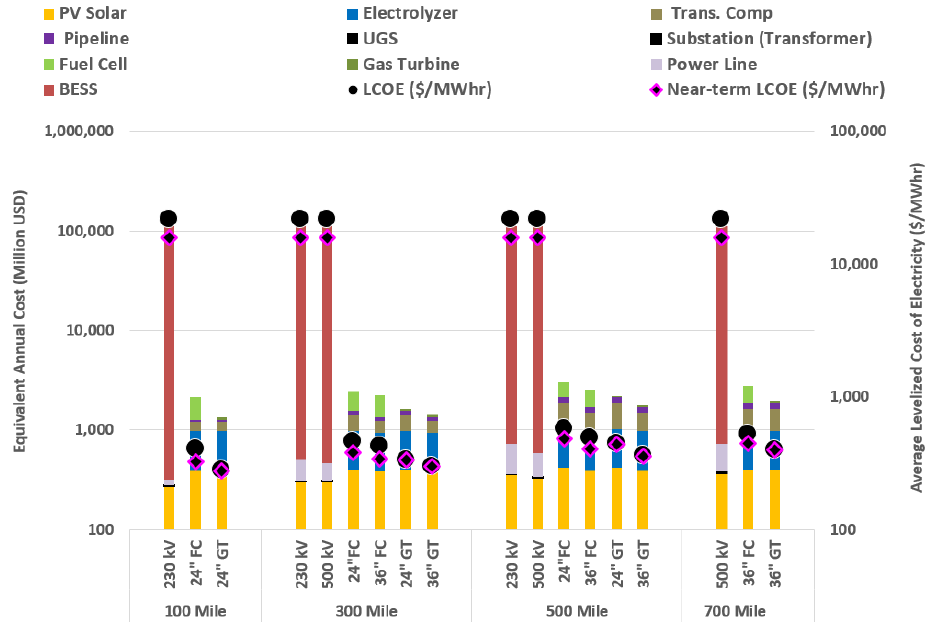
Figure 7. Equivalent annual cost breakdown and levelized cost of electricity scenario is for 1200 MW peak demand scenario, in which the all-electric pathway meets 100% of